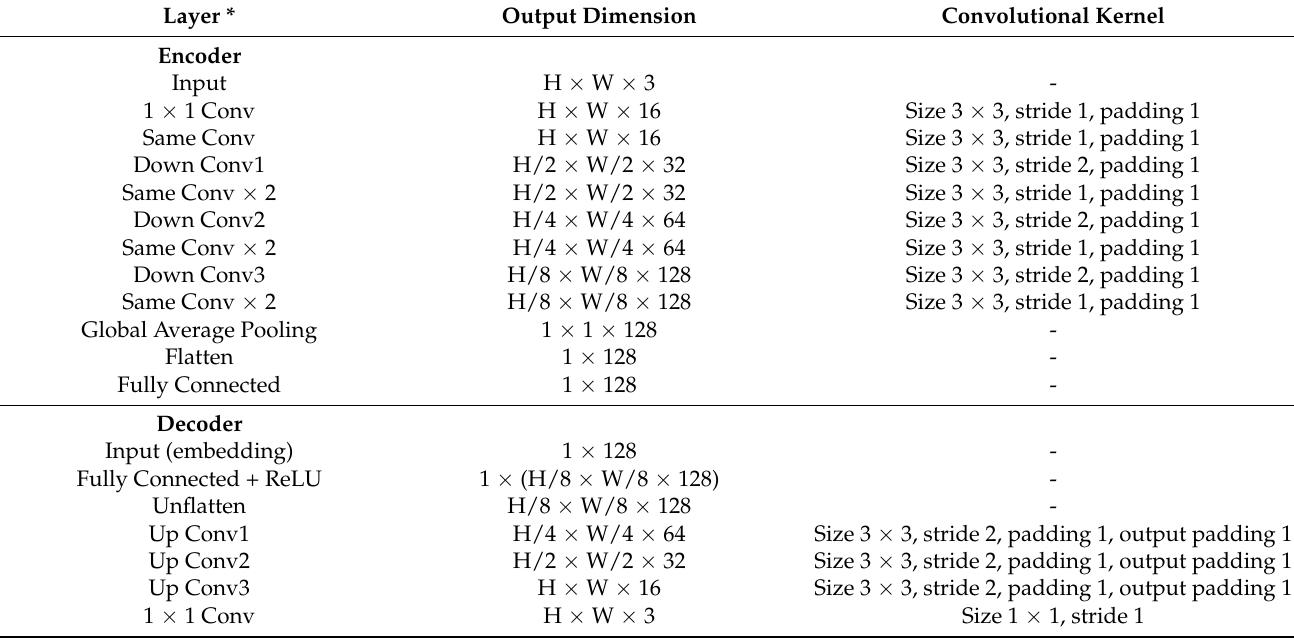
Table 4. Architecture of Model MT autoencoder.